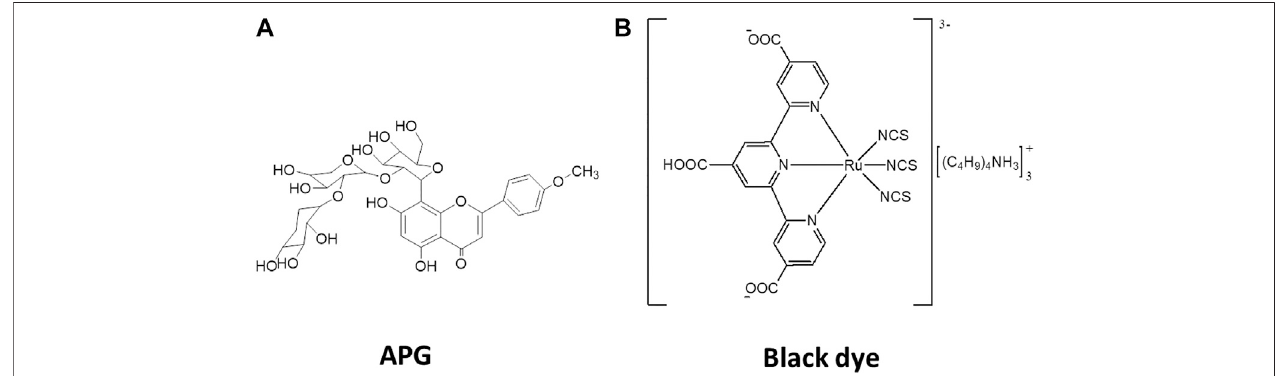
FIGURE 1 | Isolated dye molecule with chemical name: Apigenin-4 ′ -methylether-8C- β -D-glucosyl-(1 ’ → 6)-2 ″ -O- β -[xylopyranosyl-[1 ′′′′ → 2 ‴ )-O- β -xylopyranosyl (A) , and 2 D -structure of the black dye (B) .